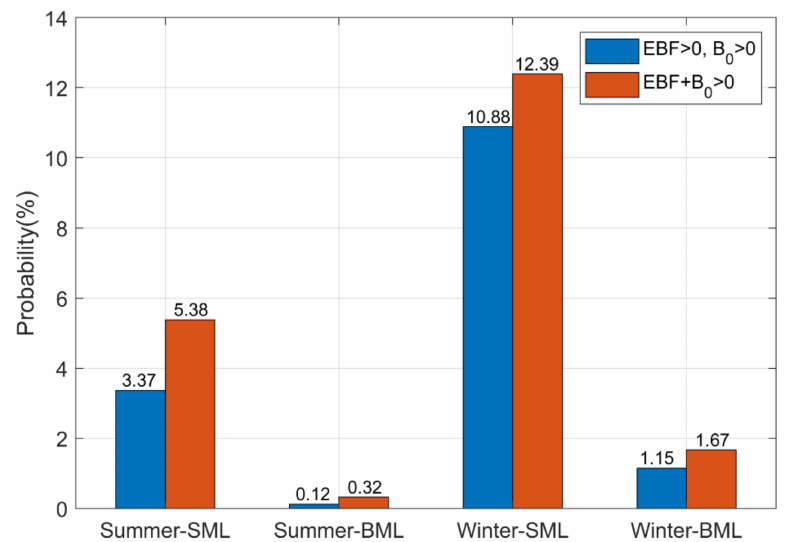
Figure 14. The SI activity occurrence probability assessing by different criteria in CROCO2. SML, the ocean surface mixed layer. BML, the base of the surfaced mixed